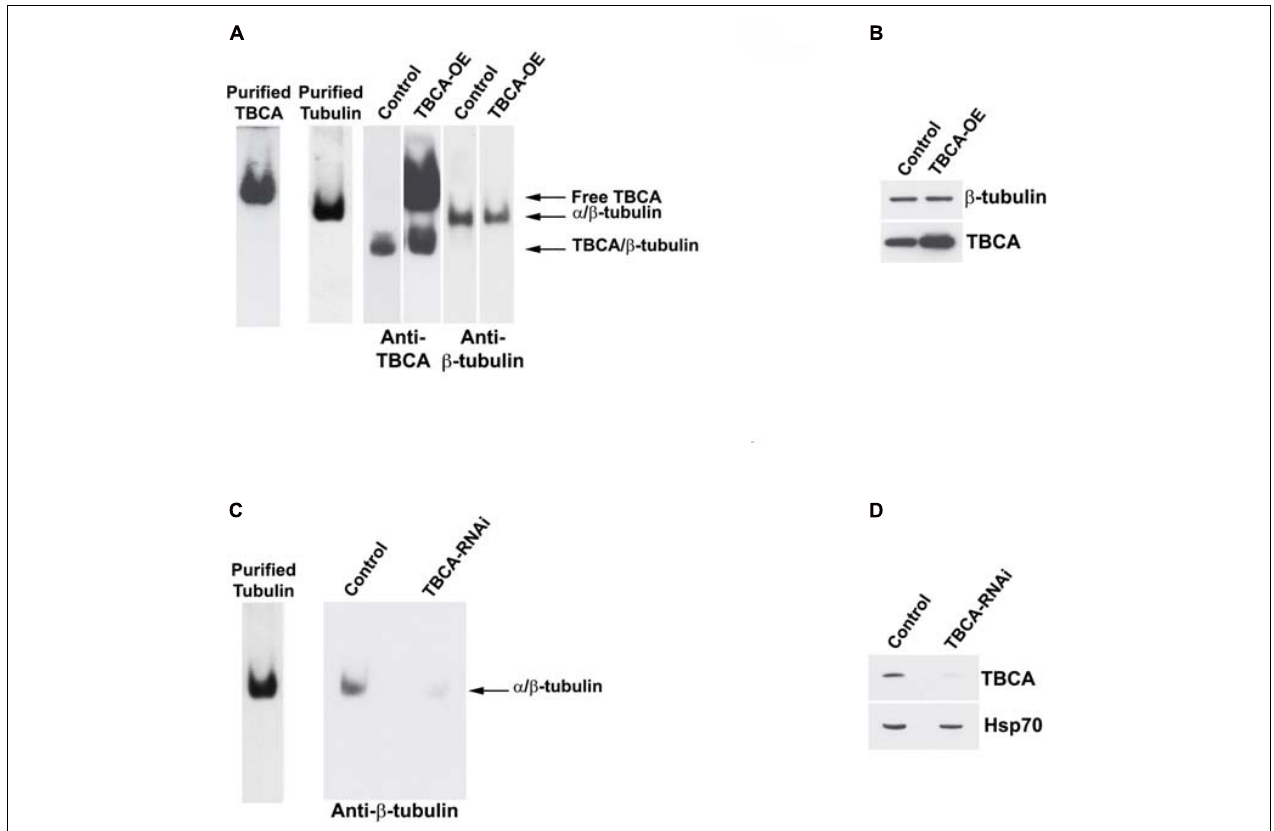
FIGURE 5 | Native tubulin heterodimers levels decrease in response to TBCA overexpression and TBCA siRNA. HeLa cells were transfected with TBCA-pcDNA3 (TBCA-OE), and control cells were transfected with empty pcDNA3. 24 h after transfection, native protein extracts were prepared. Equivalent amounts of protein soluble fraction (30 µ g) were analyzed by non-denaturing gel electrophoresis Native-PAGE) (A) and by 16.5% Tricine–SDS–PAGE (B) followed by Western blot with antibodies directed to TBCA and β -tubulin. (A) In native gels, TBCA overexpression is clearly detected by the increase of the amount of free TBCA and the TBCA/ β -tubulin complex. Tubulin heterodimer levels decrease when TBCA is overexpressed. (B) The denaturing analysis using Tricine–SDS–PAGE showed that β -tubulin levels do not change in response to TBCA overexpression. 24 h after TBCA siRNA transfection (see Nolasco et al., 2005 for details and controls), protein extracts were prepared. Equal amounts of protein soluble fraction (30 µ g) were analyzed by non-denaturing gel electrophoresis (6% Native-PAGE) (C) and by 16.5% Tricine–SDS–PAGE (D) , to check the TBCA knockdown efficiency, followed by western blot with antibodies against β -tubulin, TBCA and Hsp70. (C) TBCA knockdown also causes a decrease in the tubulin heterodimer amount. (D) Cells transfected for 24 h with TBCA siRNAs show a reduction in levels of TBCA. Hsp70 protein levels were used as a loading